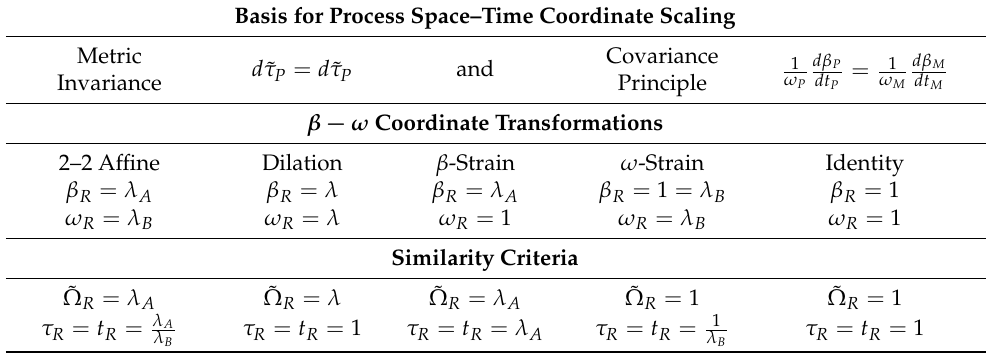
Table 1. Scaling methods and similarity criteria that result from two-parameter transformations [14]. Basis for Process Space–Time Coordinate